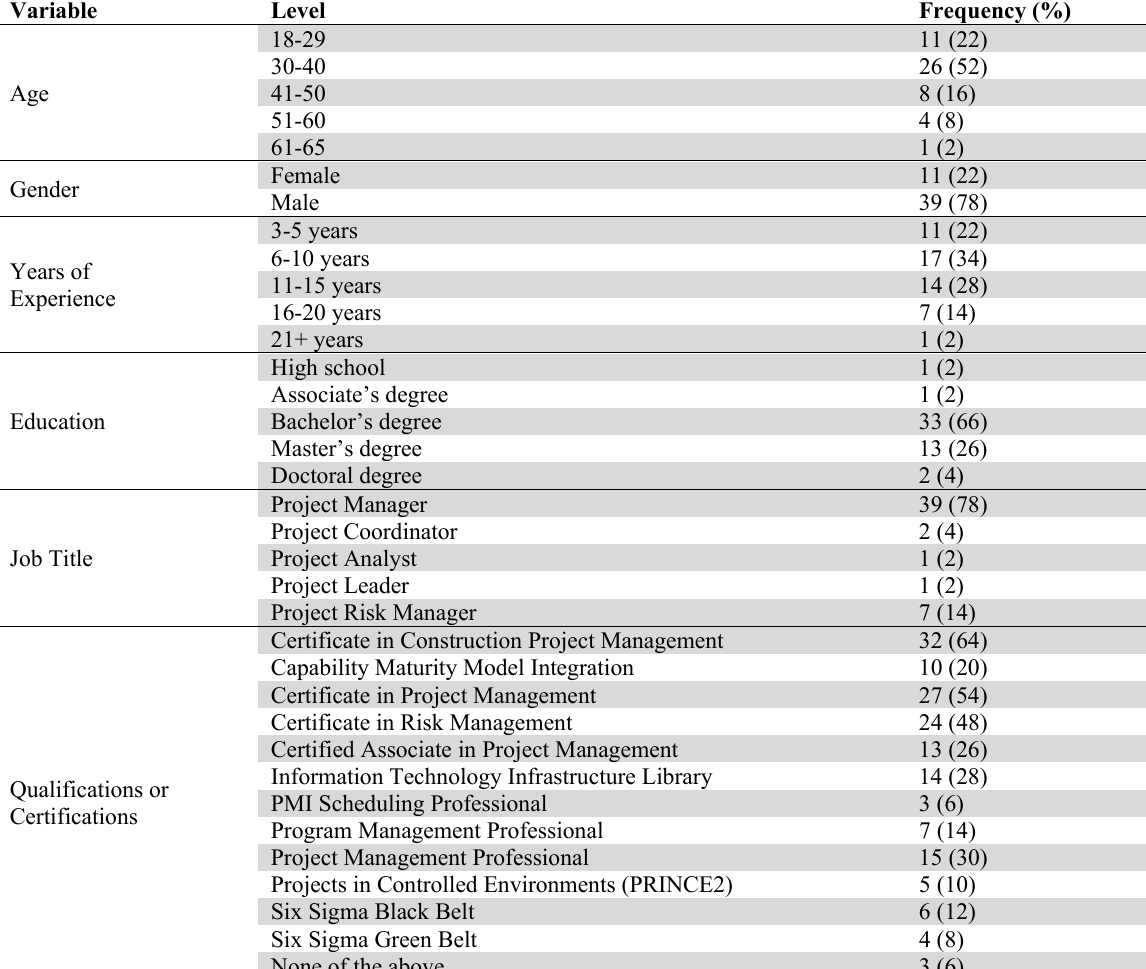
Frequencies and percentages of demographics